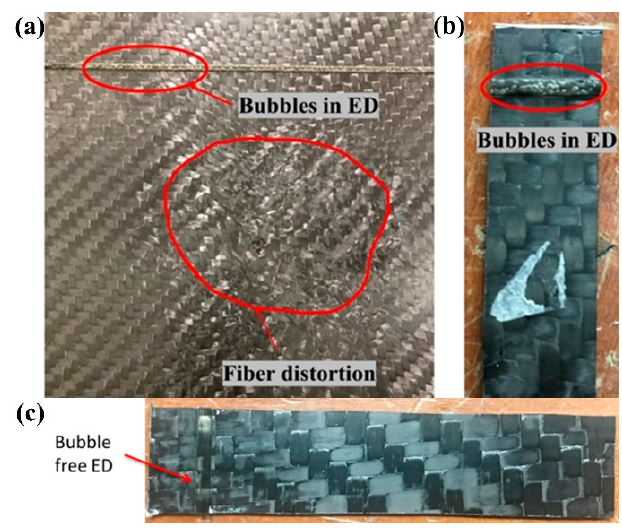
Figure 4. ( a ) Manufacturing trial showing the bubbles and fiber distortion, injected using 200 cP resin; ( b ) Bubbles entrapped in the ED during manufacturing at 100 cP, 2-bar injection pressure and 505 mbar outlet vacuum; and, ( c ) Manufactured bubble-free ED laminate with recommended parameters.